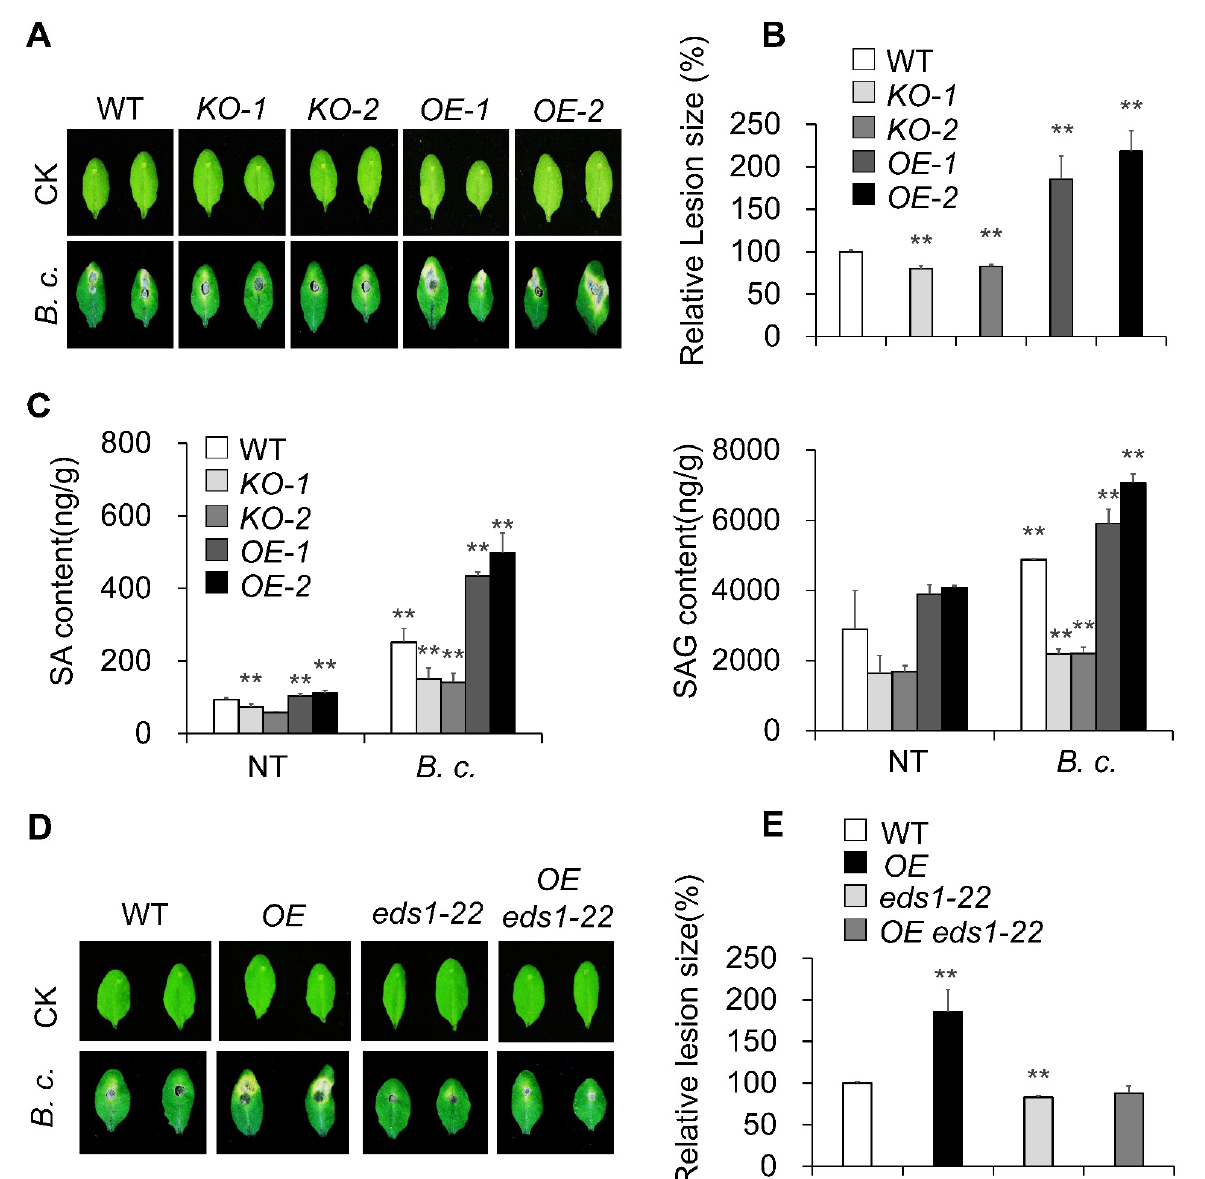
Figure 4. MACP2-weakened plant resistance depending on SA pathway to fungal pathogen. ( A ) Phenotypes of leaves from 4-week-old wild-type, MACP2-KO mutants, and MACP2-OEs plants in response to B. cinerea infection. Added B.c. on leaf surface and photographed 3 days after treatment. ( B ) Relative lesion size of wild-type, MACP2-KOs , and MACP2-OEs leaves after 3 days of B. cinerea infection. The lesion size was calculated by ImageJ and relative lesion size was calculated by comparing the values from treated leaves versus mock leaves. Asterisks indicate significant differences from the wild-type. ** p < 0.01 by Student’s t test. ( C ) SA contents detection of wild-type, MACP2-KO mutants, and MACP2-OEs adult plants during B. cinerea infection. The contents of SA and SAG were measured by LC-MS. The “g” in “ng/g” represented the fresh weight. The experiments were biologically repeated three times with similar results. Error bars represent SD. n = 3 biological replicates. ** p < 0.01 by Student’s t test. ( D ) Phenotypes of leaves from 4-week-old wild-type, MACP2-OE, eds1-22, and MACP2-OE eds1-22 leaves in response to B. cinerea infection. ( E ) Relative lesion size of wild-type, MACP2-OE, eds1-22, and MACP2-OE eds1-22 leaves after 3 days of B. cinerea infection. Asterisks indicate significant differences from the wild-type. ** p < 0.01 by Student’s t test.2.5. MACP2 Differentially Modulates Plant Sensitivities to Fungal and Bacterial Pathogens via the SA Signaling